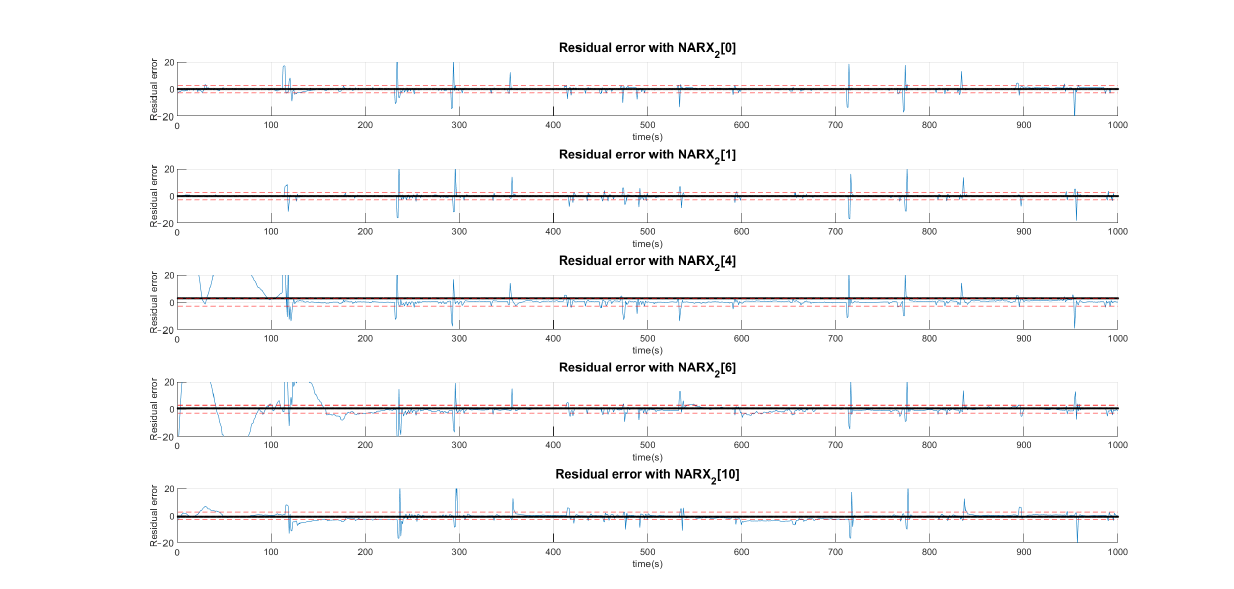
Figure 17. Residual analysis with the third network layer (Layer 2), excluding those that did not have limits close to zero in the second